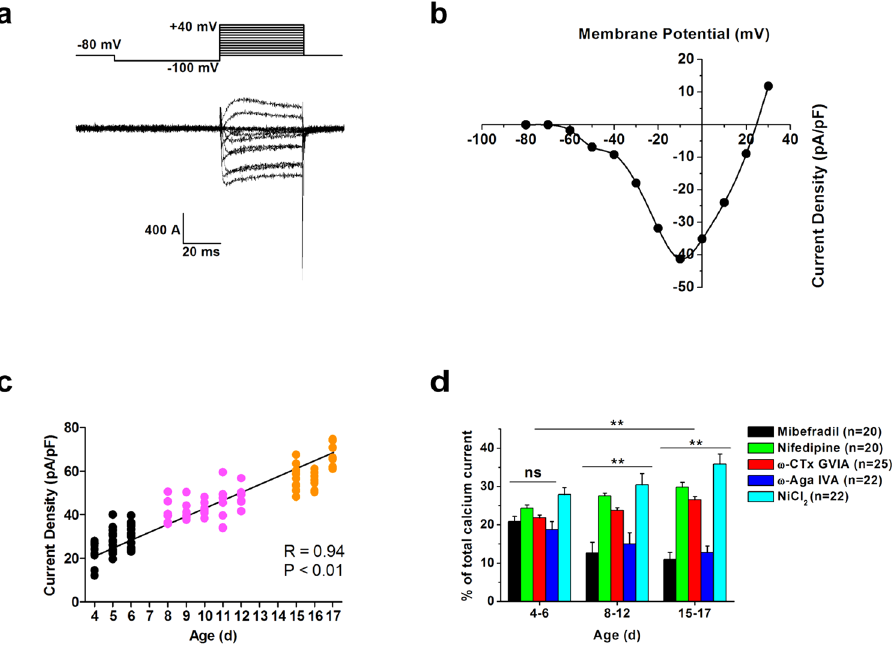
Figure 1. VGCC currents in Bushy neurons. ( a ) Whole-cell currents recorded from a bushy neuron in AVCN. The cell was held at − 80 mV and hyperpolarizing to − 100 mV before depolarizing to various test potentials from − 100 to + 40 mV in 10 mV increment at 5 sec intervals. ( b ) Current-voltage relationships for data in A measured at the peak current amplitudes showed both LVA and HVA VGCC currents. The peak inward current activated positive to about –70 mV and peaked at about –10 mV. Charge carrier, 5 mM Ba 2 + . ( c ) Correlation between the age and the total VGCC current density in bushy neurons. Bushy neurons were divided into three age groups (P4-6, black circles; P8-12, magenta circles; P15-17, orange circles). ( d ) Developmental changes in VGCC current in bushy neurons. The cells were bathed in 5 mM external barium. The extent of inhibition by Mibefradil (1 µ M; black bars; n = 20), nifedipine (10 µ M; green bars; n = 20), ω -CTx GVIA (1 µ M; red bars; n = 25), ω -Aga IVA (500 nM; blue bars; n = 22) and NiCl 2 (50 µ M; cyan bars; n = 22) was quantified and compared to show the contribution of each antagonist-sensitive calcium channels in three age groups (P4-P6, P8-P12 and P15-P17). Five One-way ANOVA tests were further used to determine whether there were any significant differences between the fraction of each subtype current in three age groups. ** P < 0.01, ns, not significant, two-way ANOVA with Bonferroni post hoc